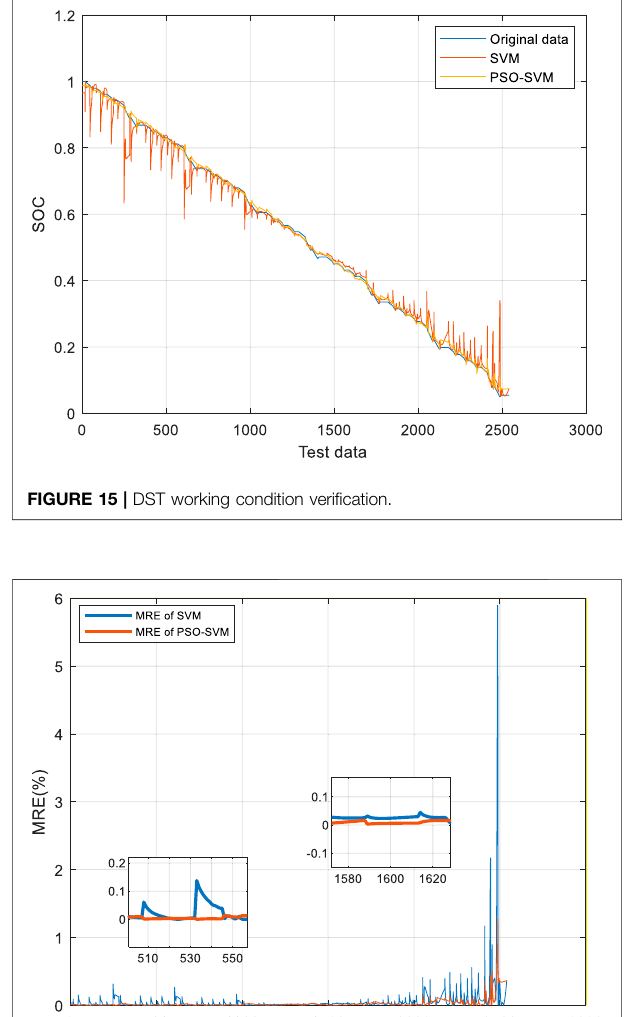
Figure 16 . The SOC estimation error under DST